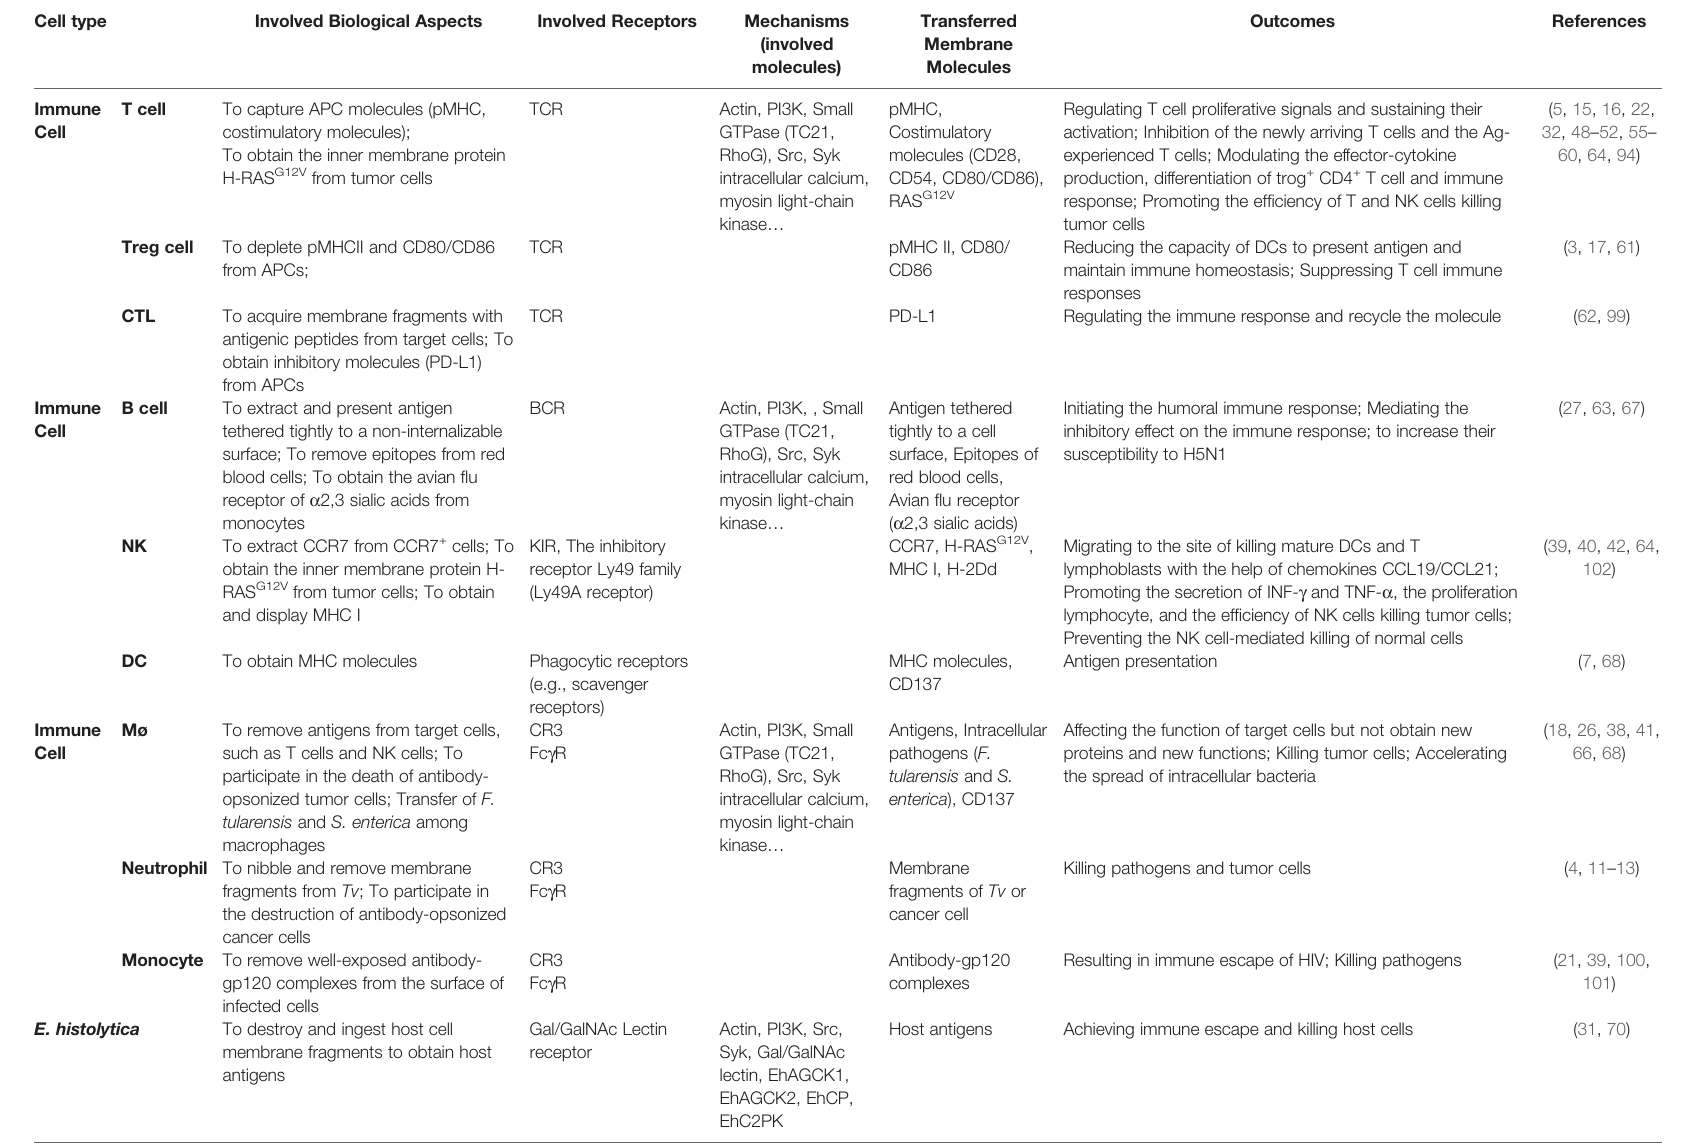
TABLE 1 | Compared the trogocytosis by different cell